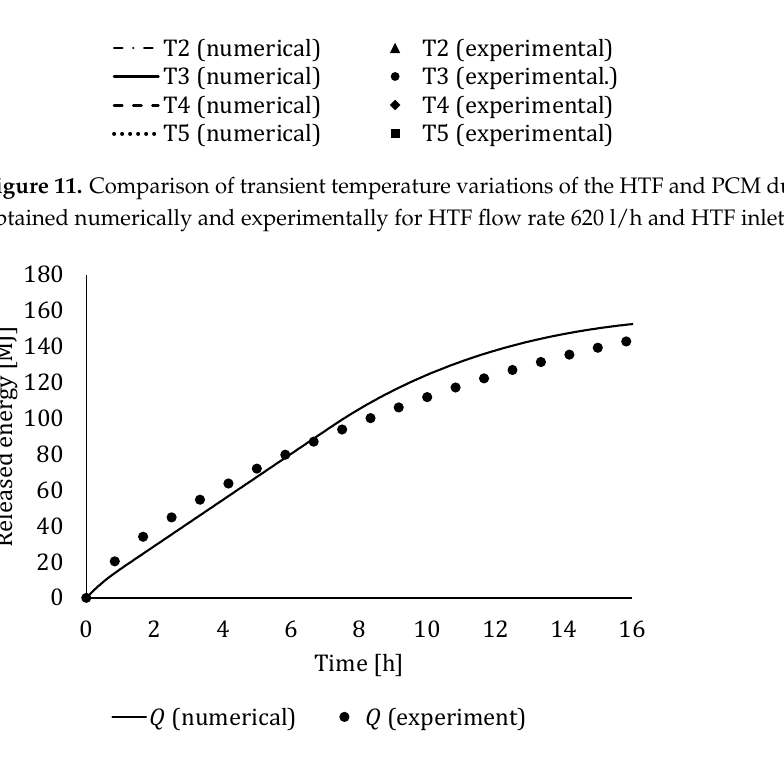
Figure 12. Comparison of accumulated energy during solidification obtained numerically and experimentally for HTF flow rate 620 l/h and HTF inlet temperature 7 °C.